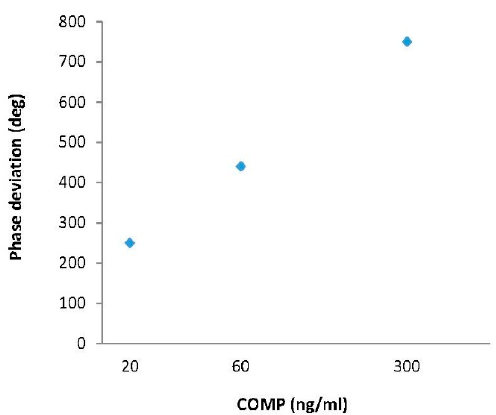
Figure 14. Phase shifts in terms of COMP